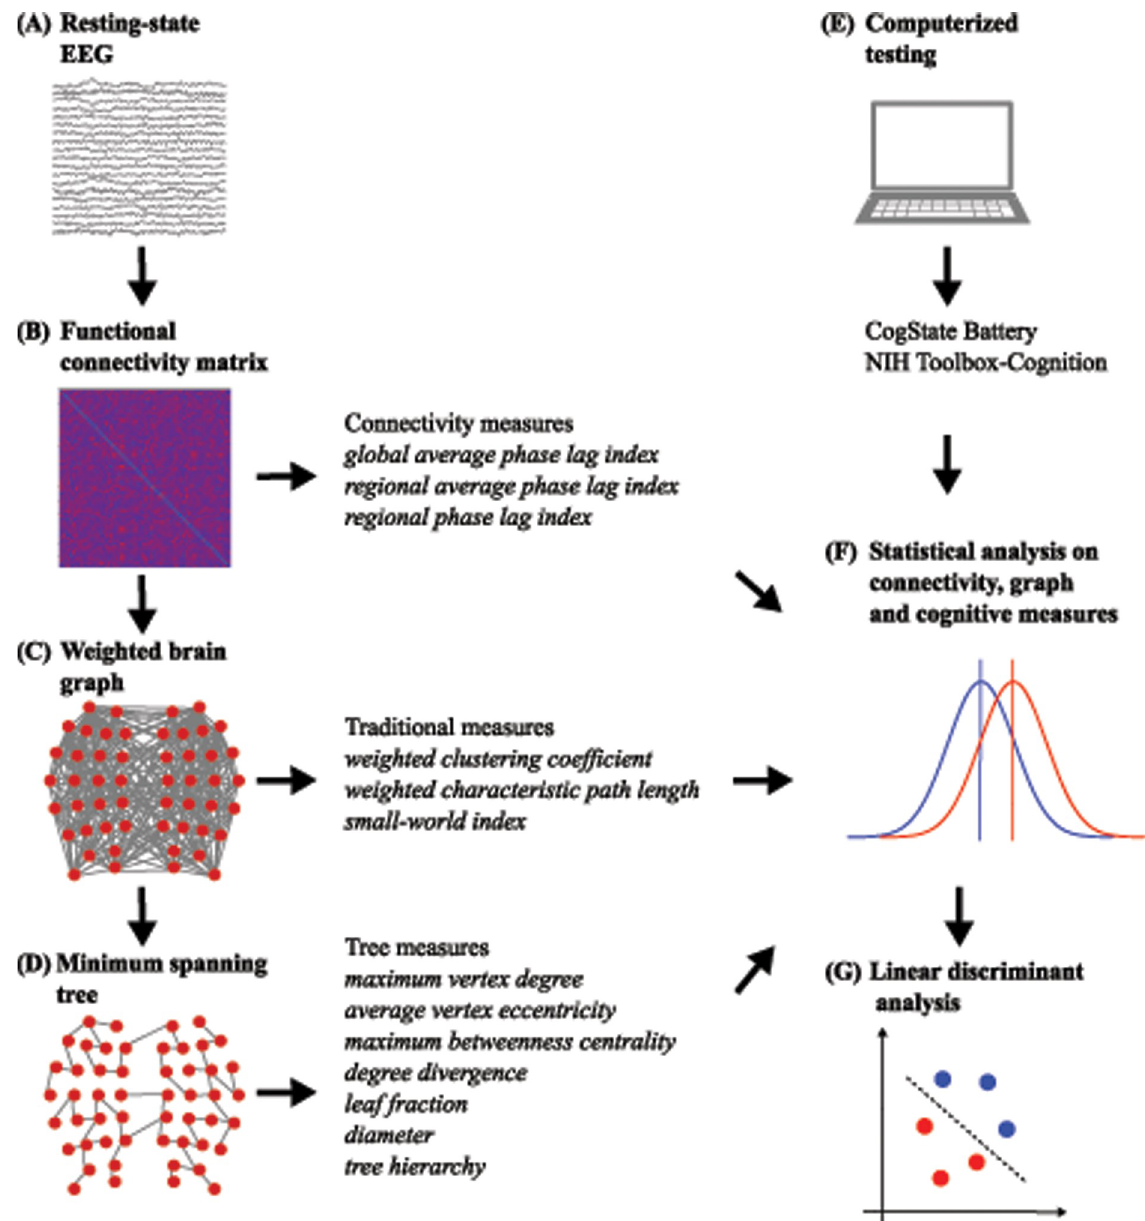
Fig 1. Schematic illustration of the proposed method in this study. (A) For each subject, resting-state EEG data were acquired. (B) A functional connectivity matrix was obtained from the EEG time-series data by computing the phase lag index. From the connectivity matrix, global and local connectivity measures were derived. (C) The connectivity matrix uniquely represents a brain graph, from which traditional measures were computed. (D) A minimum spanning tree of the brain graph was constructed and several tree measures were computed. (E) Two laptop computerized neuropsychological screening batteries, CogState and NIH Toolbox-Cognition were chosen to assess specific aspects of cognitive functioning. (F) Statistical differences between controls and MCIs in functional connectivity, traditional measures, MST measures, and cognitive tests were computed. (G) The obtained significant between-group differences were used as features in a stepwise linear discriminant analysis.